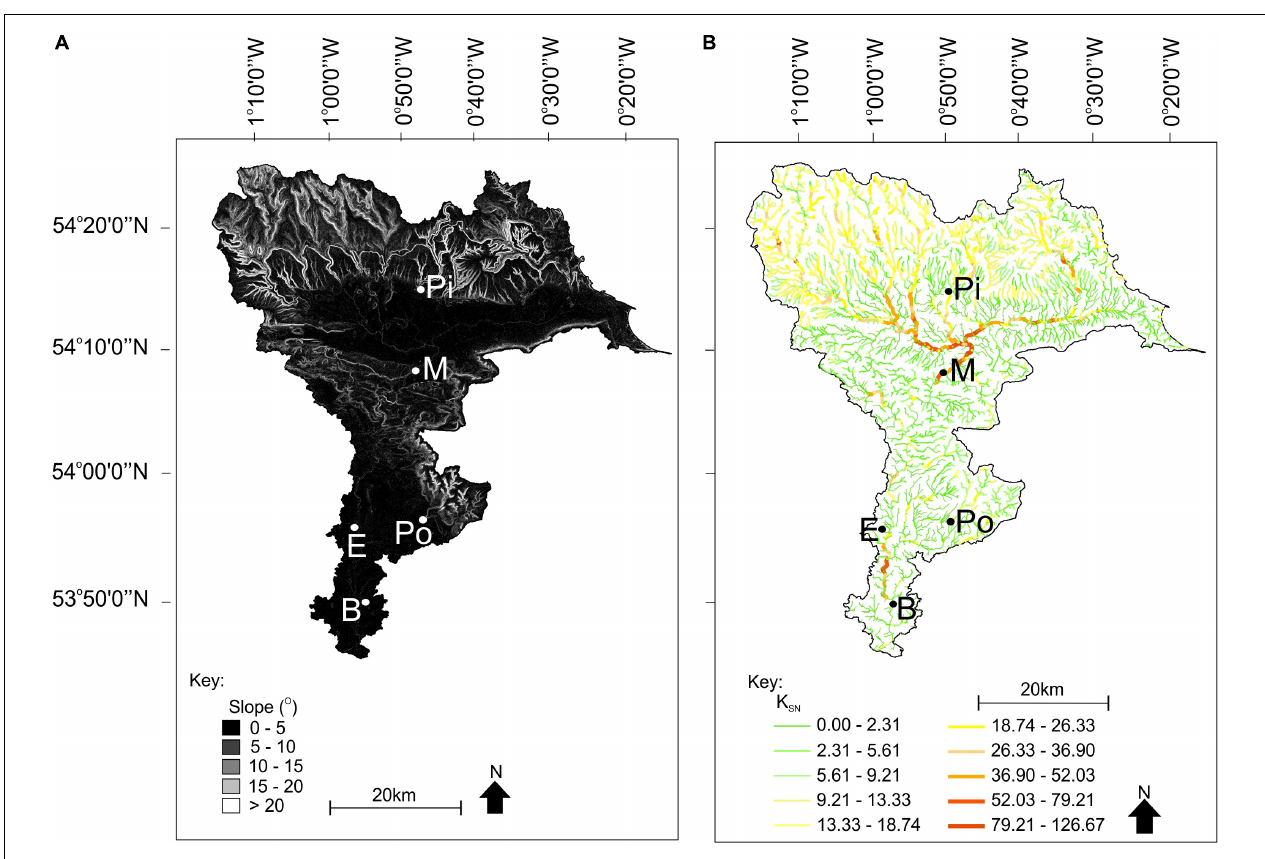
FIGURE 2 | (A) Slope and (B) normalized steepness index of the River Derwent Catchment. Locations shown; Pi, Pickering; M, Malton; Po, Pocklington; E, Elvington; and B,